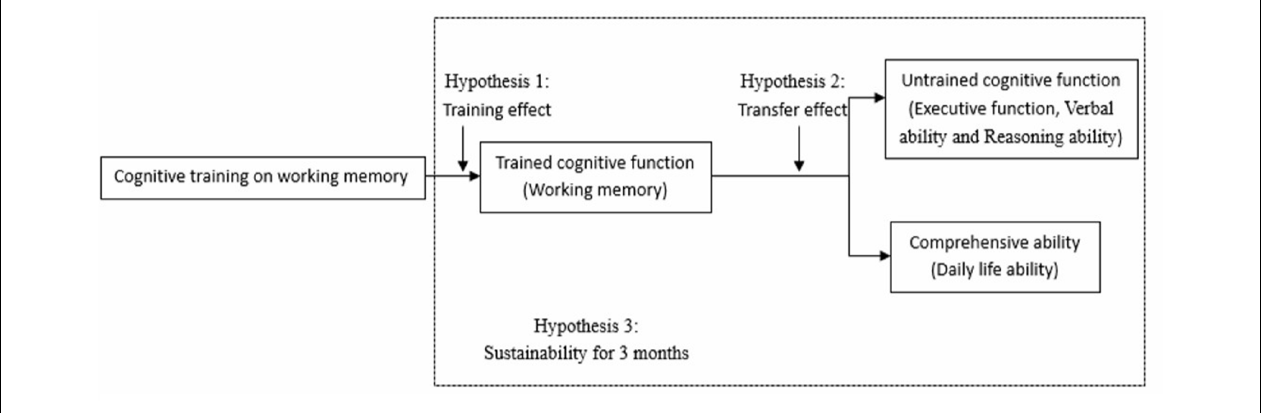
FIGURE 1 | Hypothesis of cognitive training